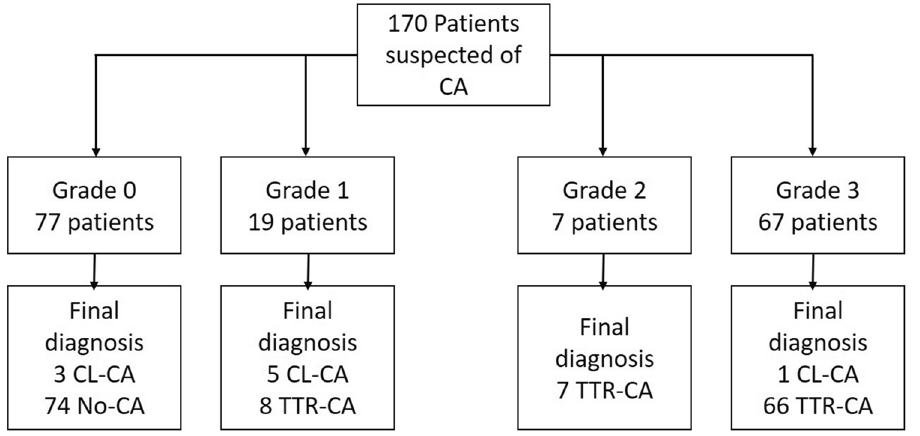
Figure 2. Patient’s flow chart in this study group.